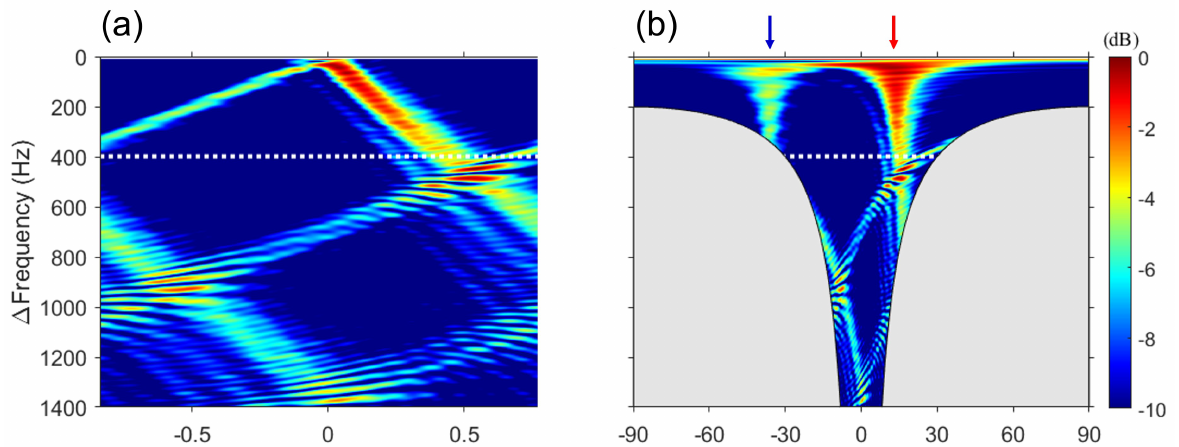
Figure 4. ∆ f – k analysis of the simulated data. ( a ) Difference frequency–wavenumber domain and ( b ) difference frequency–angle domain. The output of the ∆ f – k analysis is averaged similarly to that of FD beamforming. The ∆ f – k analysis and Figure 3 are identical, except for the gray-shaded region. Compared with the featureless f – k analysis, the ∆ f – k analysis clearly exhibits two lines. Considering the range between the source and VLA and aperture of the VLA, the maximum limit frequency of the far field of the array (white dotted line) is 400 Hz. Angle spread can occur because of the near-field effect on difference frequencies higher than the maximum limit frequency, as shown in ( a , b ).